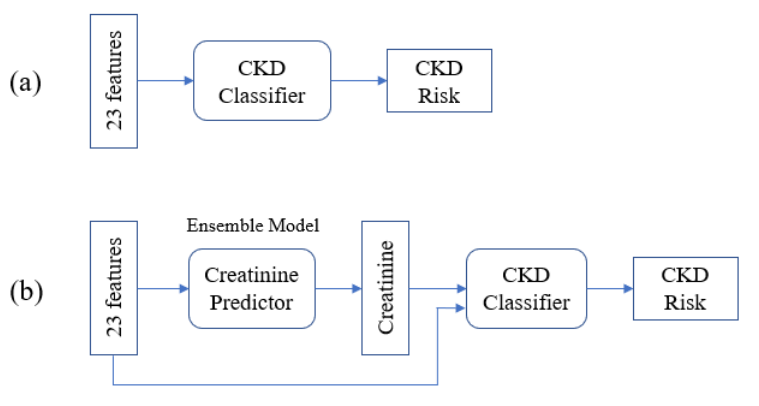
Figure 4. Two methods of predicting Chronic Kidney Disease (CKD) risk. ( a ) directly training a CKD classifier to predict CKD risk; ( b ) predict creatinine first and then combine its value with 23 features to predict the risk of